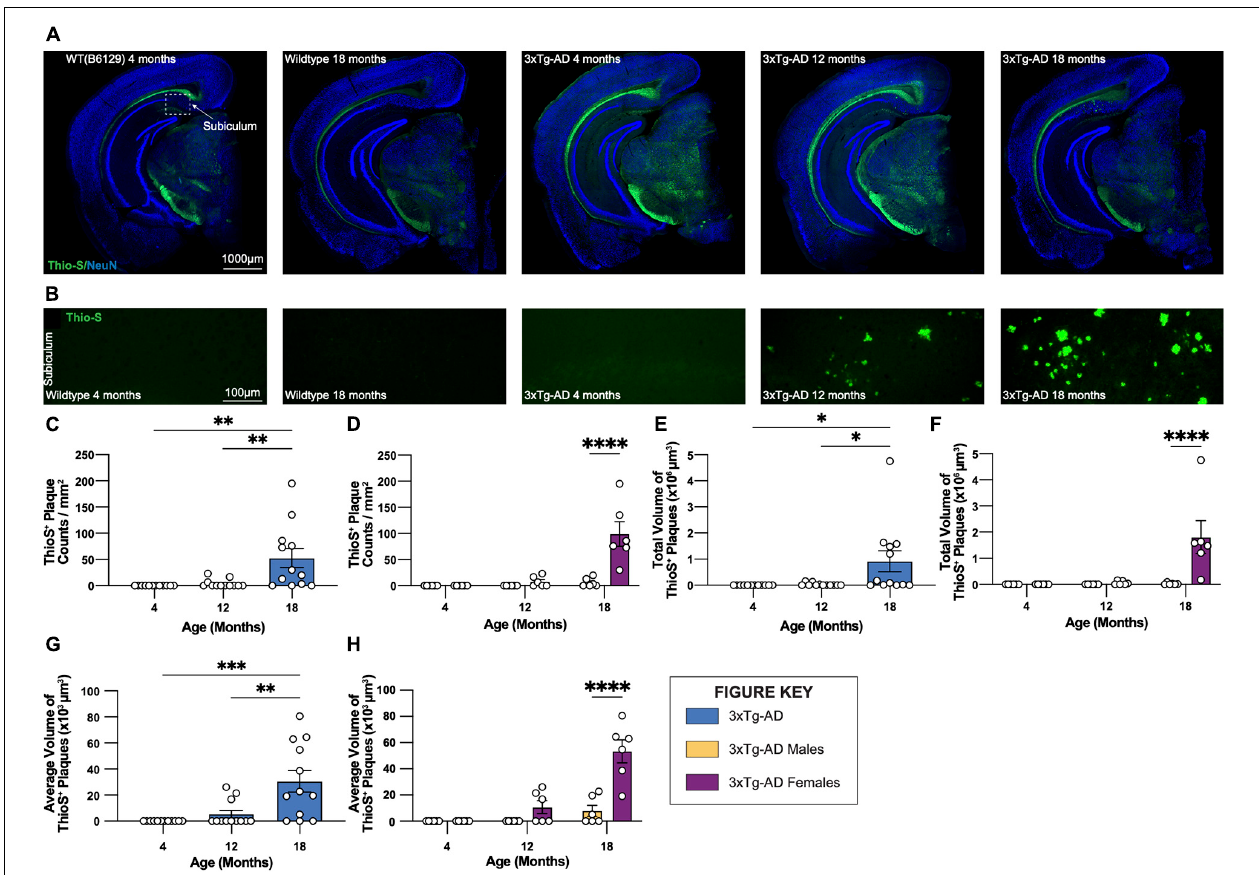
FIGURE 2 | Fibrillar amyloid plaques increase in size and number in 18-month-old female 3xTg-AD mice. 3xTg-AD plaque burden was assessed with Thioflavin-S staining at each time point. (A) Representative stitched brain hemispheres of WT and 3xTg-AD mice shown with Thio-S staining at 4- and 18-month, and 4-, 12-, and 18-month timepoints, respectively, counterstained with NeuN. (B) Representative confocal images of Thio-S + plaques in subiculum hippocampal regions of WT and 3xTg-AD mice across timepoints displaying increased number of fibrillar amyloid plaques. (C,D) Quantification for density of Thio-S + plaques in the subiculum hippocampal region per square millimeter by genotype and sex. (E,F) Quantification of total volume of Thio-S + plaques by genotype and sex demonstrating age- and genotype-associated increases in total volume of plaques. (G,H) Quantification of average volume of Thio-S + plaques showing an increase in the average volume of a plaque related to age and genotype. n = 6 mice per genotype/age/sex. Data are represented as mean ± SEM. ∗ p ≤ 0.05, ∗∗ p ≤ 0.01, ∗∗∗ p ≤ 0.001, ∗∗∗∗ p ≤